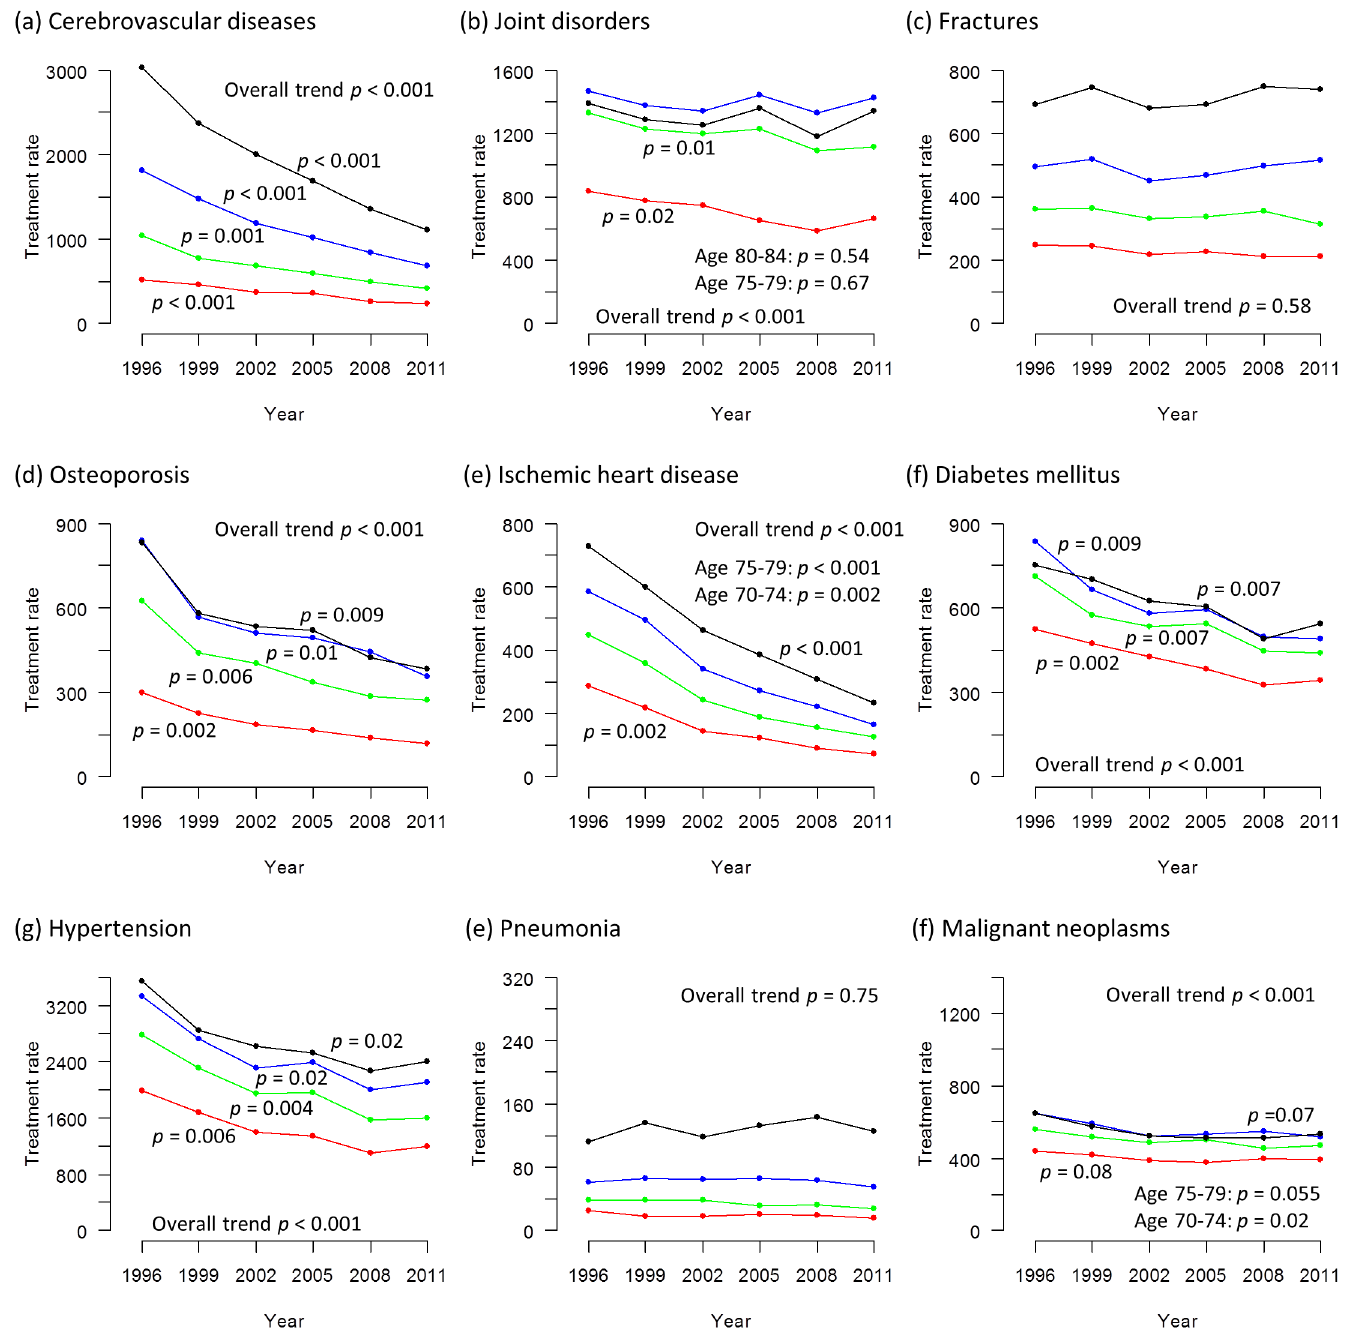
Fig 3. Trends in treatment rates of nine selected medical conditions in women from 1996 to 2011. (a) cerebrovascular diseases (b) joint disorders (c) fractures (d) osteoporosis (e) ischemic heart disease (f) diabetes mellitus (g) hypertension (h) pneumonia (i) malignant neoplasms The treatment rate is calculated as the estimated number of patients divided by the estimated population x 100,000. The black line represents those aged 80 – 84 years, the blue line represents those aged 75 – 79 years, the green line represents those aged 70 – 74 years and the red line represents those aged 65 – 69 years. The p values signify statistical significance for the trends in each age